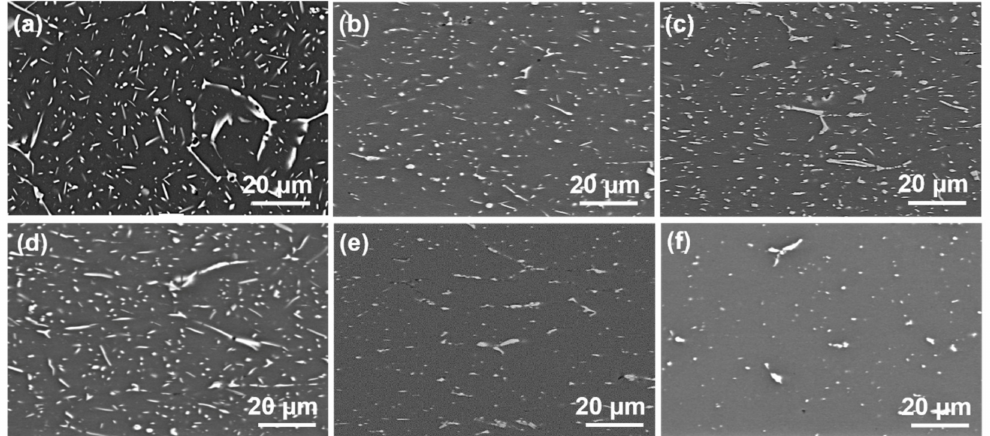
Figure 2. SEM images of 7055 aluminum alloy under spray-deposited state ( a ), 300 ◦ C/5 s − 1 ( b ), 300 ◦ C/0.001 s − 1 ( c ), 400 ◦ C/0.1 s − 1 ( d ), 450 ◦ C/5 s − 1 ( e ) and 450 ◦ C/0.001 s − 1 ( f